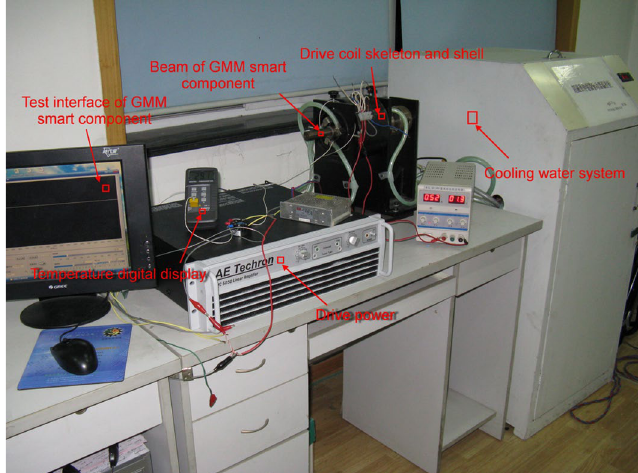
Figure 4. Smart component testing